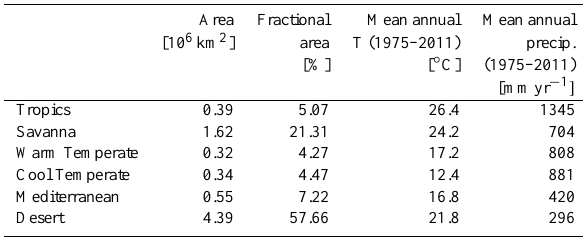
Fig. 4. Mean NPP (1990–2011), with boundaries of bioclimatic re- gions (Fig. 3, Table 5) indicated as solid lines. Table 3. Spatial extent, mean annual temperature and precipitation of the bioclimatic regions shown in Fig.